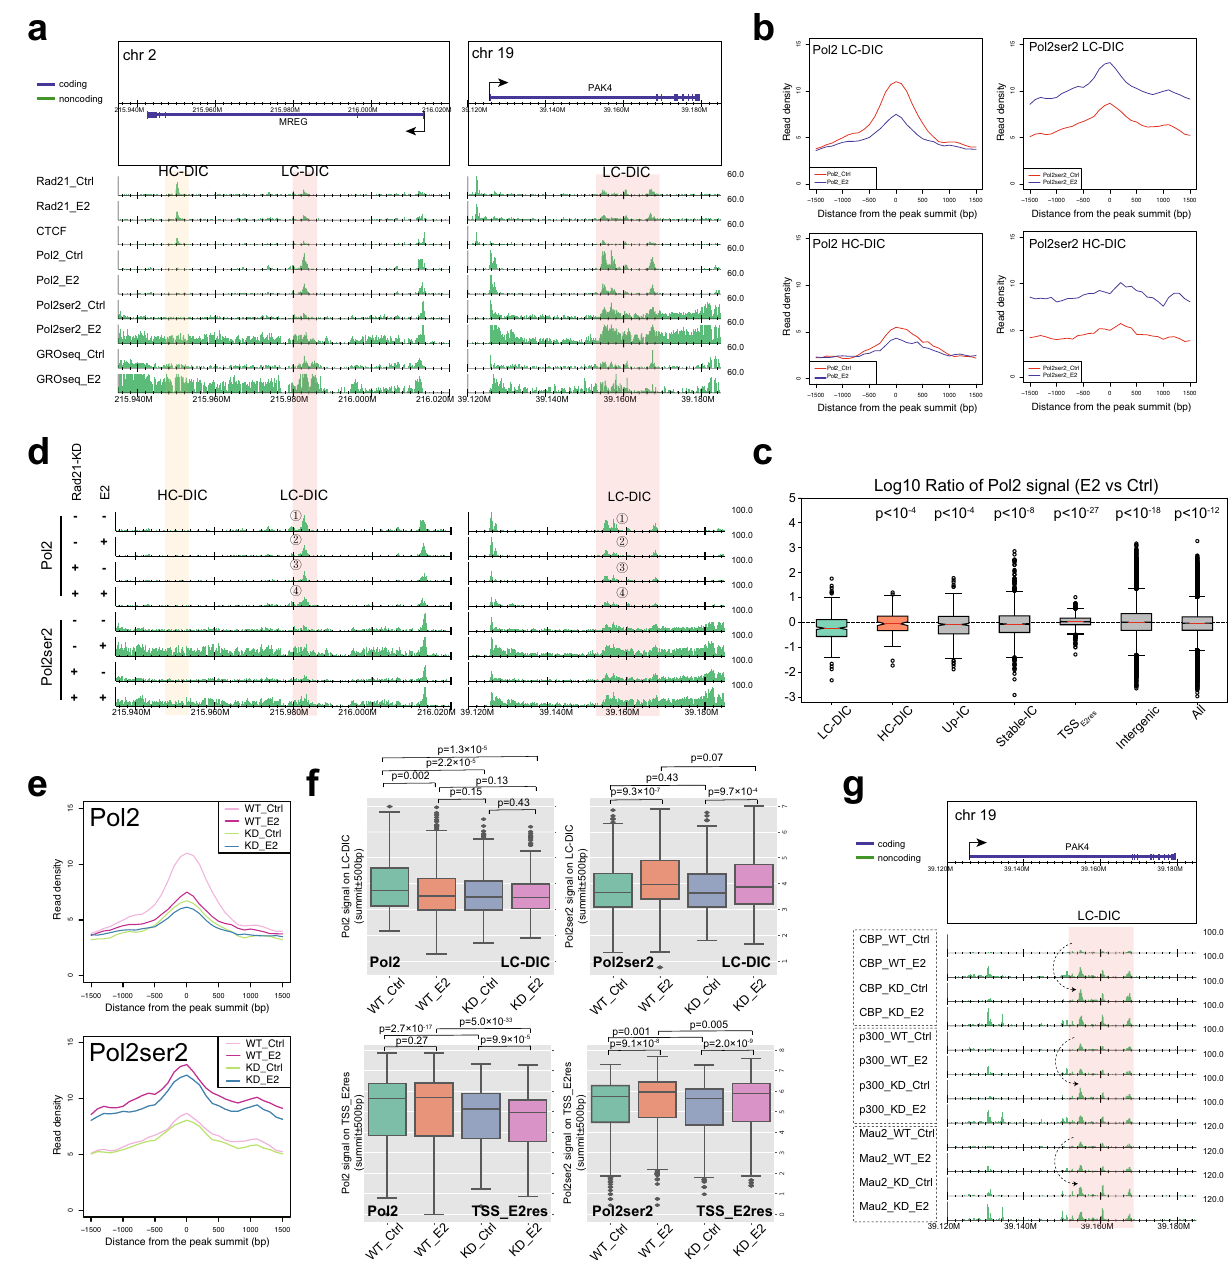
Fig. 3 Pol2 pauses on LC-DICs. a Genomic binding of Pol2 and Pol2ser2 and GRO-seq data for MREG and PAK4 loci. b Binding pro fi les of Pol2 and Pol2ser2 on LC-DICs or HC-DICs, under control and E2 conditions. Reads were normalized relative to the whole genome. c The log 10 value of the ratio E2/Ctrl with respect to the Pol2 signal on various cohesin sites. p values (Mann – Whitney U test, two-sided) were calculated between LC-DICs ( n = 417) and other cohesin sites including HC-DIC ( n = 141, p = 5.0 × 10 − 5 ); Up-IC (up-regulated intragenic cohesin, n = 680, p = 7.6 × 10 − 5 ); stable-IC (unchanged intragenic cohesin, n = 2800, p = 4.7 × 10 − 9 ); TSS E2res , (TSS of E2-responsive gene, n = 1422, p = 2.4 × 10 − 28 ); intergenic cohesin ( n = 34,566, p = 1.7 × 10 − 19 ) and all cohesin sites ( n = 96,218, p = 1.6 × 10 − 13 ), where n is the number of cohesin sites. Box plots indicate the interquartile range IQR (25 – 75%) with a line at the median. Whiskers indicate 1.5 times the IQR. Black circles represent outliers. d Visualization of Pol2 and Pol2ser2 ChIP-seq data around MREG and PAK4 . MCF-7 cells were treated as indicated. WT, wild type; KD, Rad21 knockdown; Ctrl, control; E2, estrogen. e Pol2 and Pol2ser2 binding pro fi les around LC-DICs (summit ± 1.5 kb) under four different conditions. f Quantitative comparison (Mann – Whitney U test, two-sided) of Pol2 and Pol2ser2 signals on LC-DICs ( n = 417) or TSSs of E2-responsive genes (TSS_E2res, n = 1422) under four different conditions. Multiple testing correlation with Benjamini-Hochberg method was used. Box plots indicate the interquartile range IQR (25 – 75%) with a line at the median. Whiskers indicate 1.5 times the IQR. The black diamond symbols represent outliers. Source data are provided in the Source Data fi le. g ChIP-seq results for CBP, P300 and MAU2 on PAK4 gene in WT and Rad21 knockdown MCF-7 cells with the absence and presence of E2 stimulation. Dashed arrows show increased binding events in cohesin-de fi cient